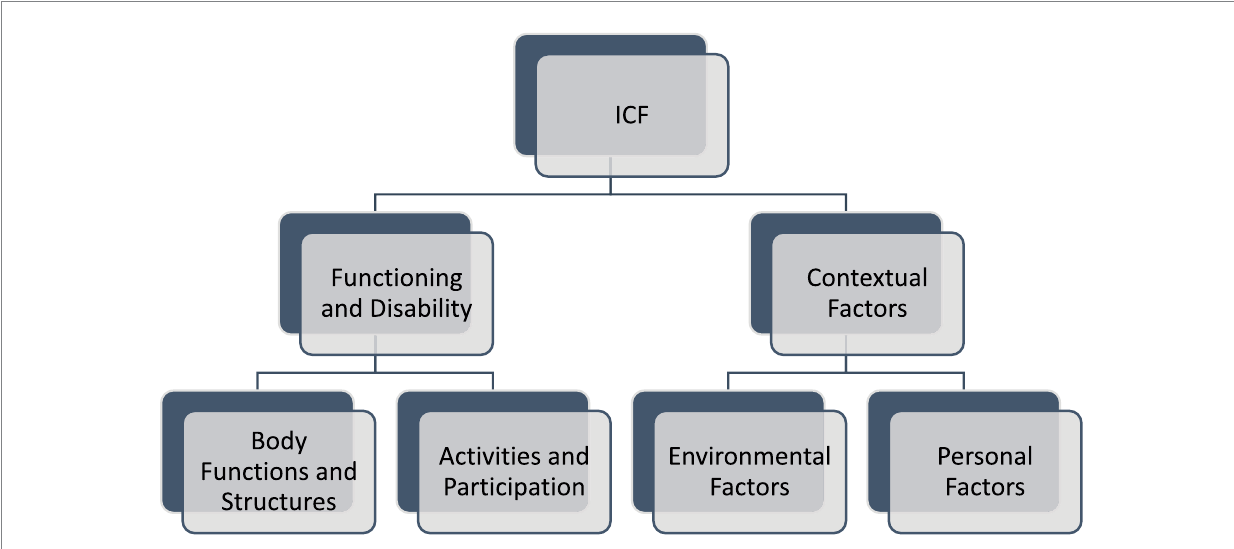
FIGURE 1 The ICF classification of health and health-related conditions for children and adult for interprofessional collaborative practice and person-centred care. The framework consists of “Functioning and Disability” and “Contextual Factors.” “Functioning and disability” is characterised by “Body functions and structures” and “Activity and participation” while “Contextual factors” refer to the environment in which a person lives. Body Functions and Structures describes actual anatomy and physiology/psychology of the human body. Activity and participation describes the person’s functional status, including communication, mobility, interpersonal interactions, self-care, learning, applying knowledge etc. Environmental Factors include factors that are not within the person’s control, such as family, work, government agencies, laws and cultural beliefs. Personal Factors include race, gender, age, educational level, coping styles etc. (Stucki,